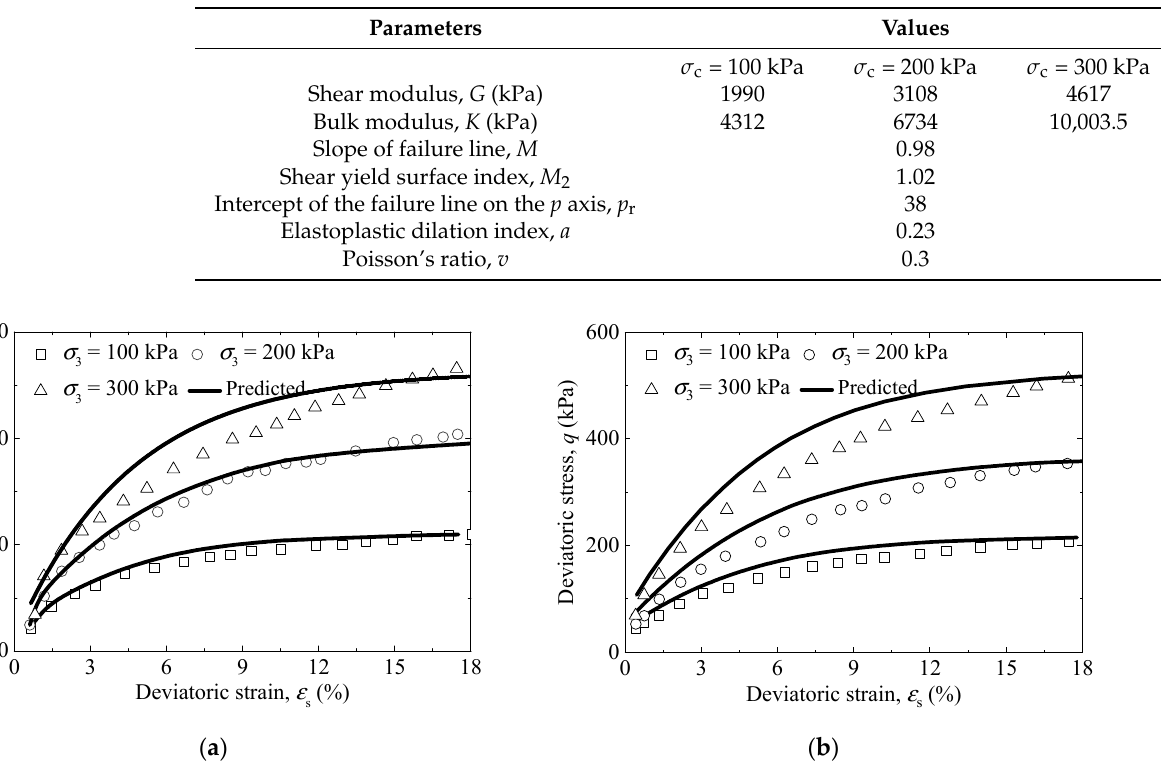
Figure 3. Comparison between predicted and observed results for stress–strain curves of saturated silty clay (data from [36]): ( a ) N FT = 3 and ( b ) N FT = 5. Table 1. Parameter values for the proposed elastoplastic model with N FT = 3 used in [36]. Table 3. Parameter values for the proposed elastoplastic model used in